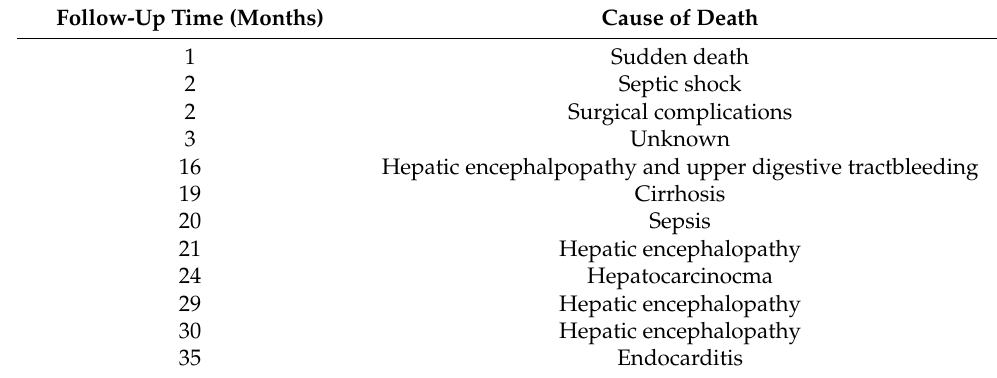
Table 1. Time and cause of death of deceased patients during follow-up. Follow-Up Time